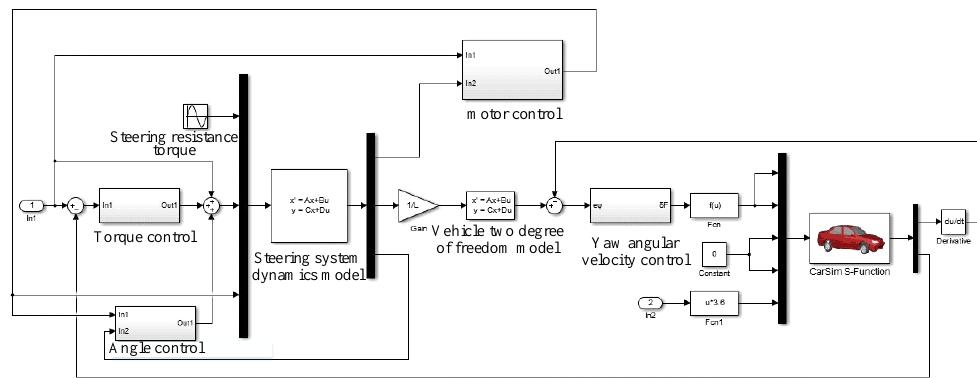
Figure 7. Overall control system based on Simulink/Carsim.